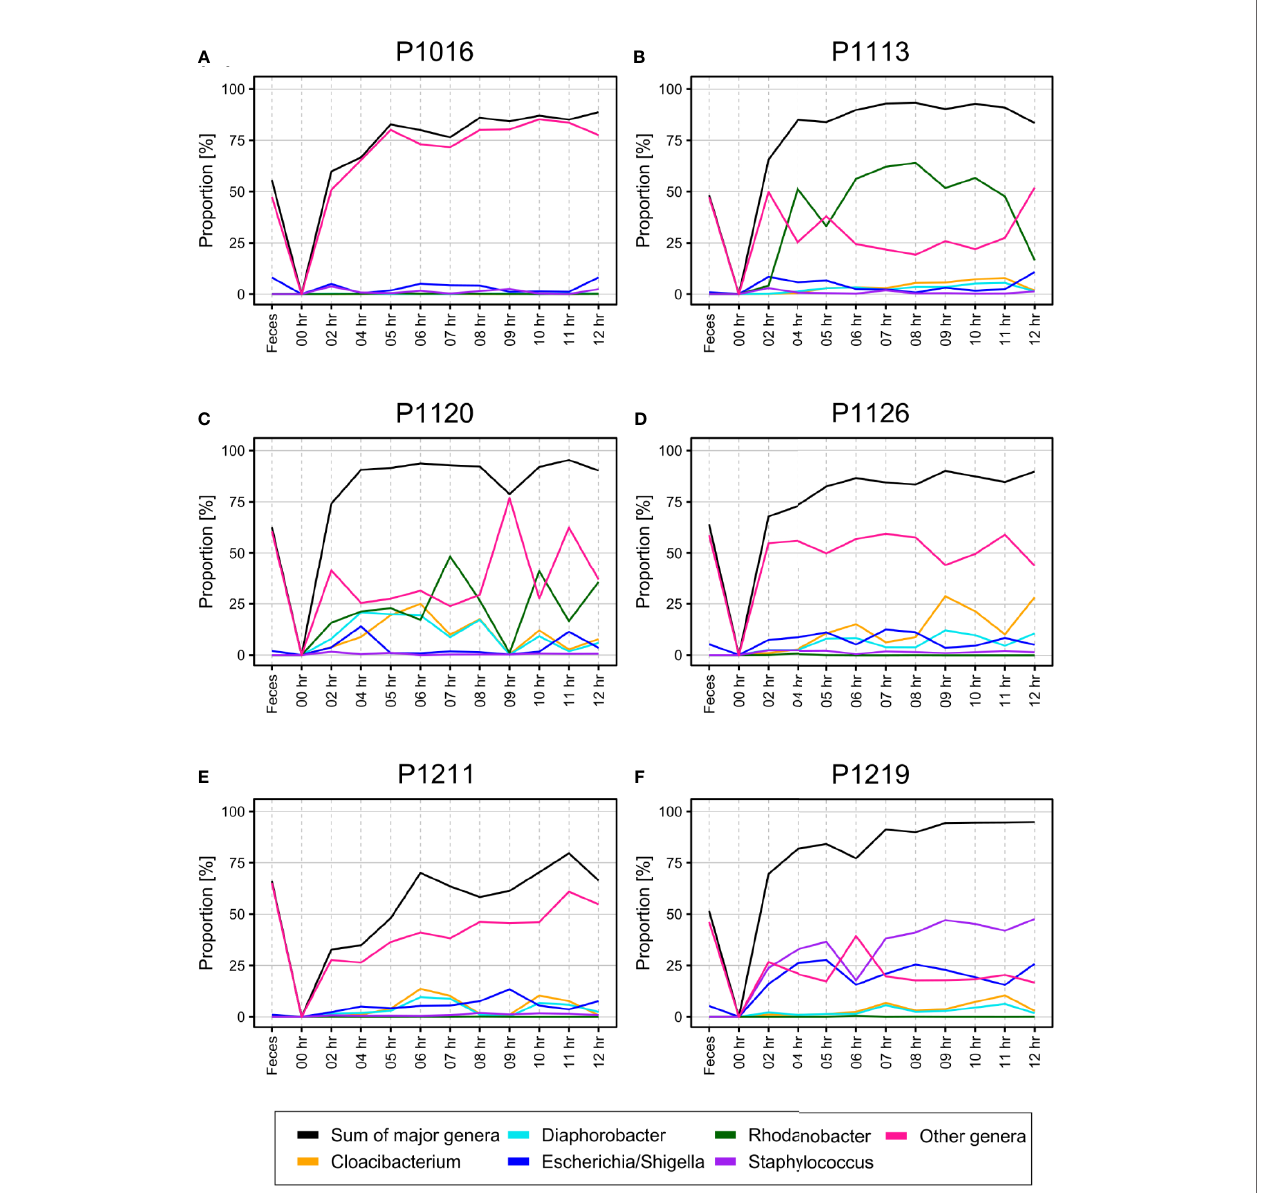
FIGURE 3 | (A – F) Percentage of newly emerged operational taxonomic units (OTUs) from each phylum in the blood of pigs with fecal-induced peritonitis. The microbiome observed at the initial time point was discarded computationally from data for all other time points, and the proportion at each time point was